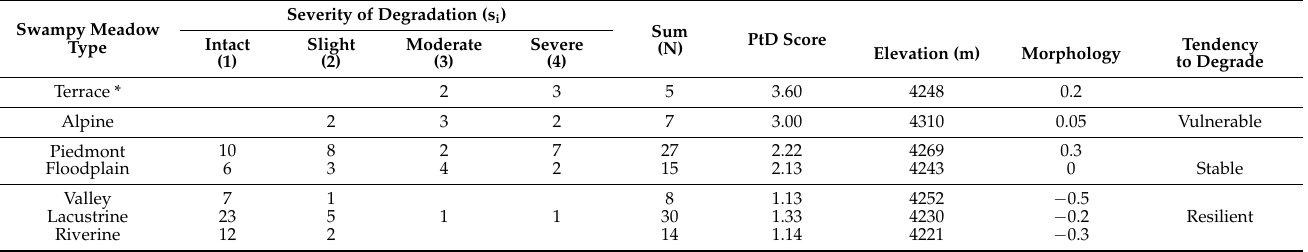
Table 2. The observed number of sampled swampy meadows ( n i ) that have been degraded to various severity levels ( s i ), the calculated PtD score by swampy meadow type, its mean elevation, and the numerical value assigned to surface morphology of the seven types of swampy meadow for the purpose of regression